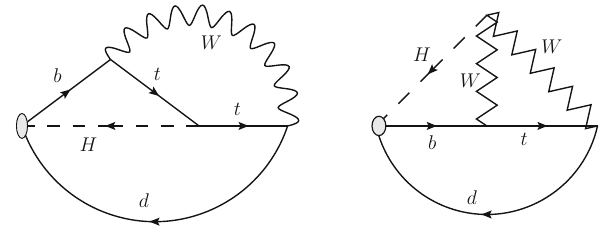
Fig. 6 ThecontributionstotheWeinbergoperatorfortheflavorchang- ing Higgs interaction Y R ( d → b ) , represented by the grey blobs to the left in both diagrams. Three gluon lines have to be attached to quark lines 5 Perturbative QCD corrections Summing all two loop contributions from Sects. 3 and 4,